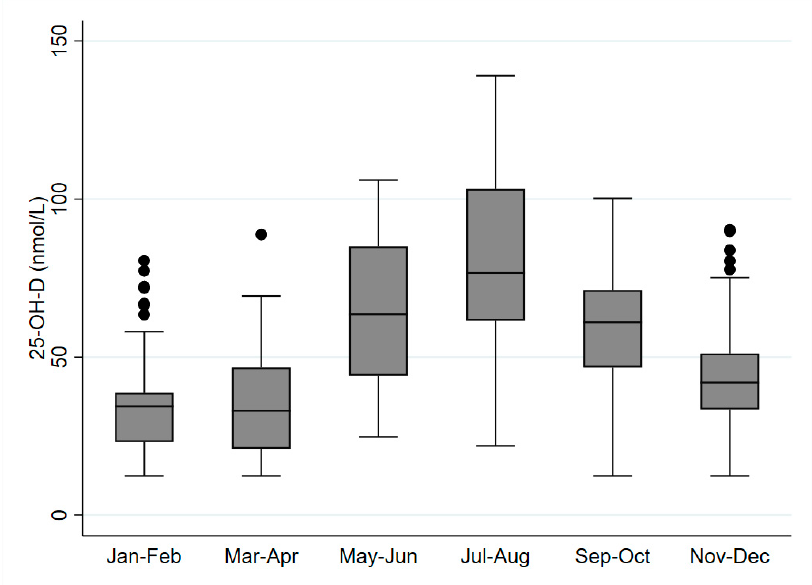
Figure 1. Box plots of the weighted (age and sex) mean serum 25(OH)D concentrations for different bi-monthly periods ( N = 280) with presentation of outliers ( • ).